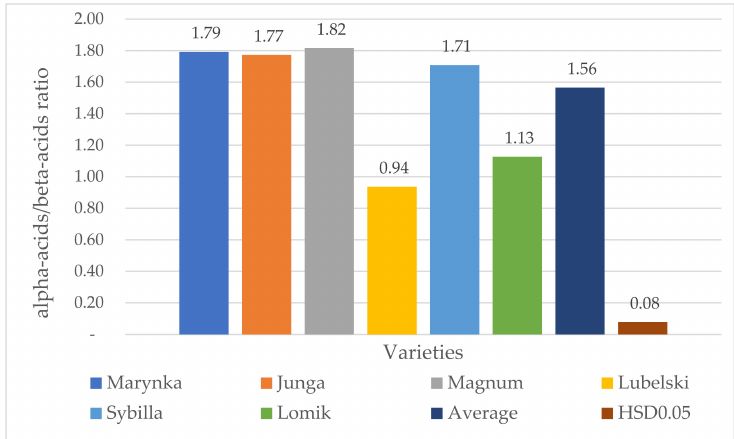
Figure 7. The ratio of alpha-acids to beta-acids in hop cones depending on the